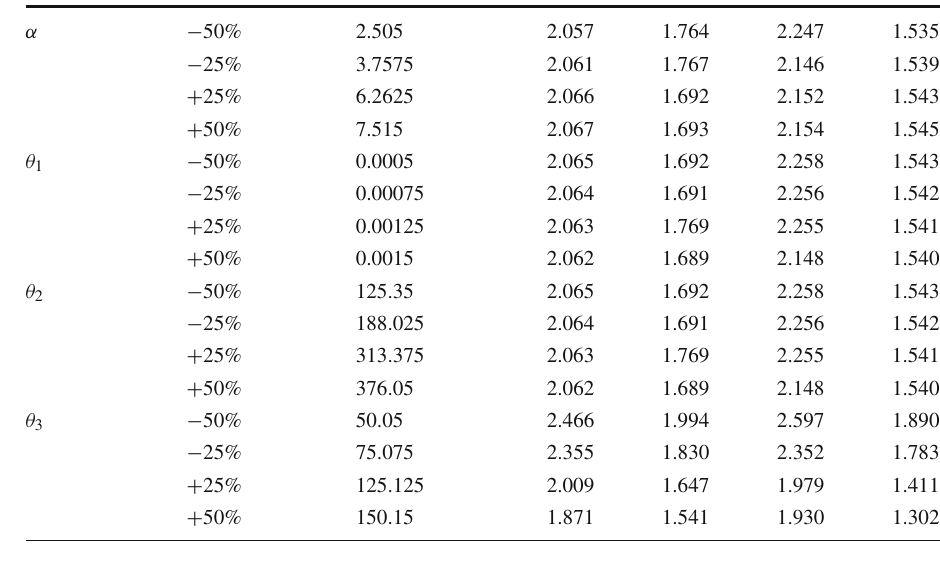
Table 7 Parameters changes value versus retailer’s